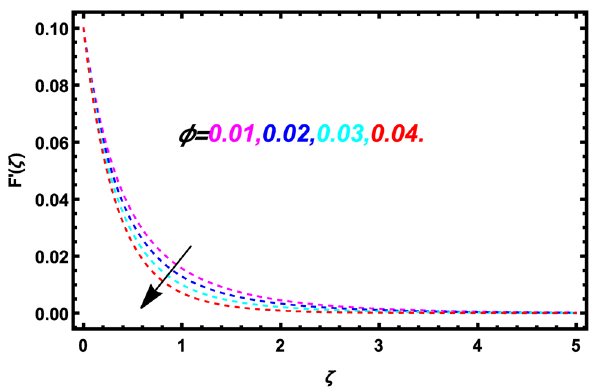
Figure 9. Demonstration of velocity curve versus φ when Fr = 0.2, k 1 = 0.1, k 2 = 0.3, M = 0.5, m = 0.2, Pr = 5.3, Ec = 0.3, ε Rd = 0.2, Sc = 0.1, ε Lb = 0.3, Pe = 0.3. t = 3.0, C = 3.0, δ = 0.3,